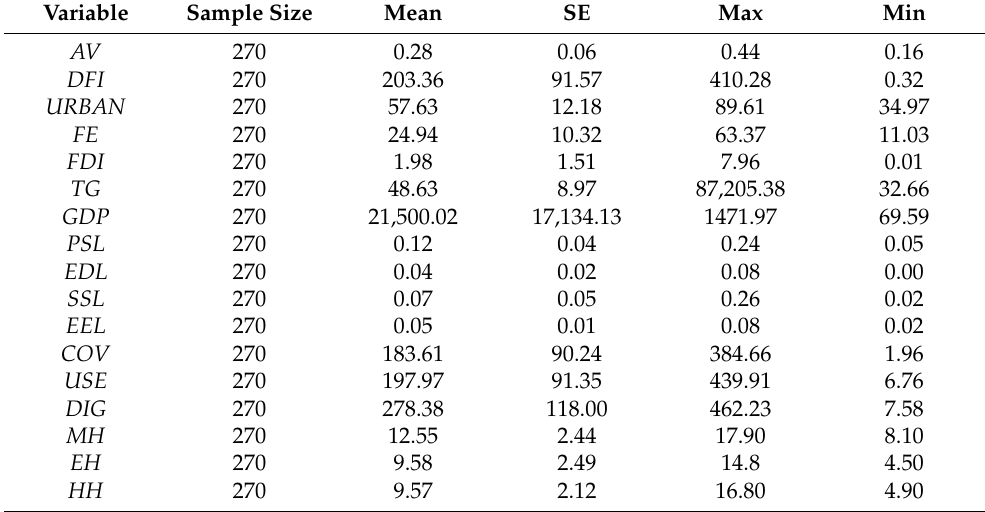
Table 3. Descriptive statistics of